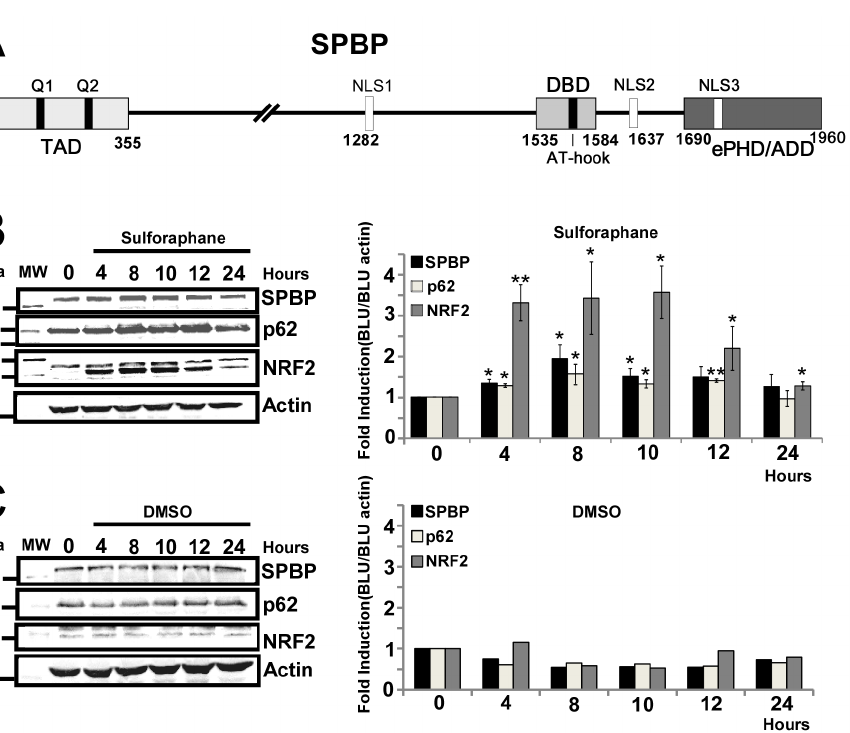
Figure 1. Sulforaphane enhances SPBP expression. ( A ) Schematic representation of the domain structure of human SPBP. TAD: trans- activation domain, DBD: DNA binding domain, NLS: Nuclear Localisation Signal, ePHD/ADD: extended PHD/ADD domain, Q1/Q2: Glutamine rich stretches. Numbers below indicate amino acid positions. ( B ) NRF2, SPBP and p62 display similar induction upon sulforaphane treatment. HeLa cells were exposed to 20 m M sulforaphane and cell extracts harvested for the indicated time points. Equivalent aliquots from the extracts were subjected to SDS-PAGE and western blot using specific anti-SPBP antibody, anti-p62 antibody, anti-NRF2 antibody or anti-actin as indicated. Fold induction calculated and correlated to actin in three independent experiments with standard deviations are shown to the right (**p , 0.01, *p , 0.05). ( C ) Control experiment showing that DMSO alone does not induce any changes in NRF2, SPBP or p62 expression levels. Equivalent aliquots of HeLa cell extracts exposed to DMSO and harvested for the indicated time points were subjected to SDS-PAGE and western blot using specific anti-SPBP antibody, anti- p62 antibody, anti-NRF2 antibody or anti-actin antibody as indicated. Fold induction calculated and correlated to actin are shown to the right.